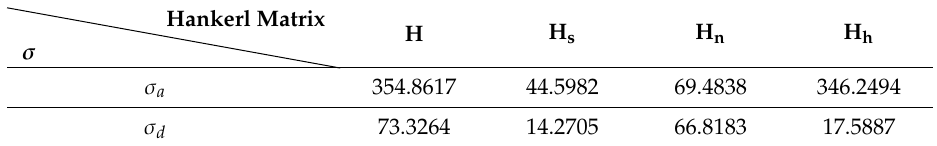
Table 2. Result singular values of the singular value decomposition SVD of matrix H, H s , H n , and H h . Hankerl Matrix σ